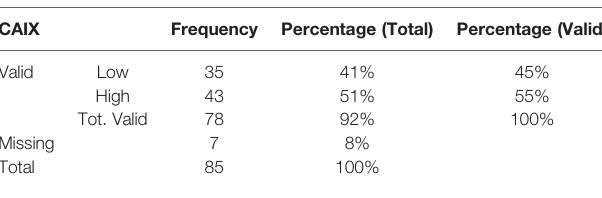
TABLE 3 | CAIX IHC tissue expression score frequency distribution in the studied